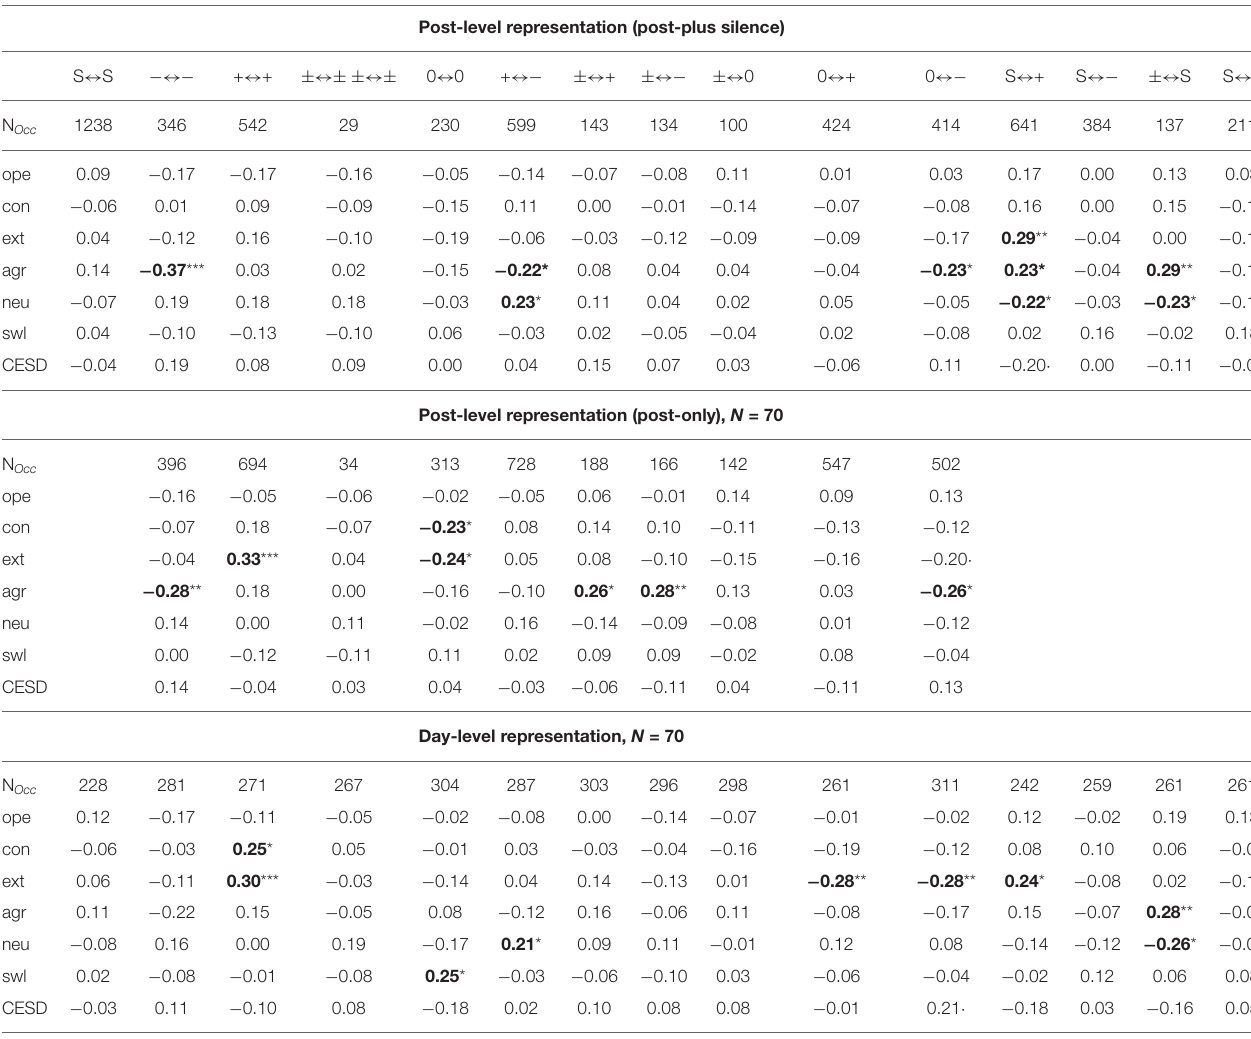
TABLE 3 | Correlations between personality, SWL, and CES-D scores and affect transitions. Number of participants N = 70. Post-level representation (post-plus